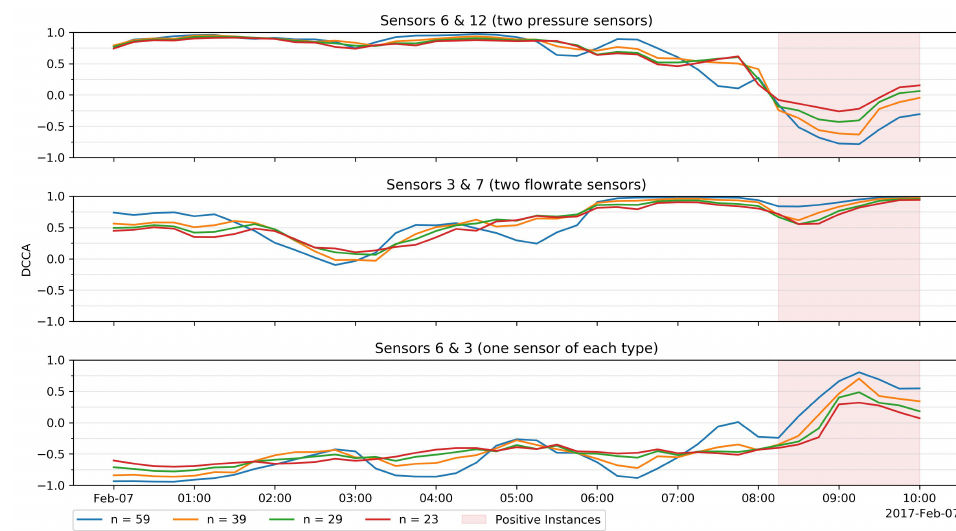
Figure 16. Impact of parameter n on DCCA in three selected pairs from 7 February 2017, using a time window of 120